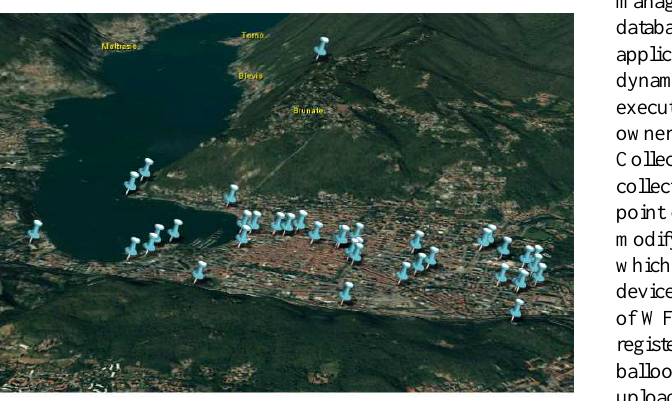
Figure 3. Example of POIs 3D visualization at high altitudes